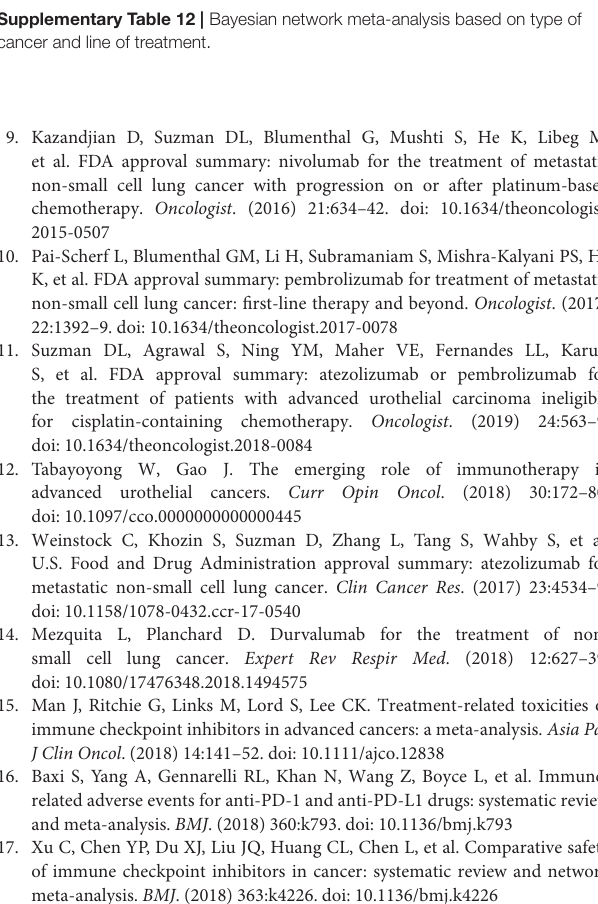
Supplementary Table 8 | Meta-regression for treatment-related adverse events and immune-related adverse